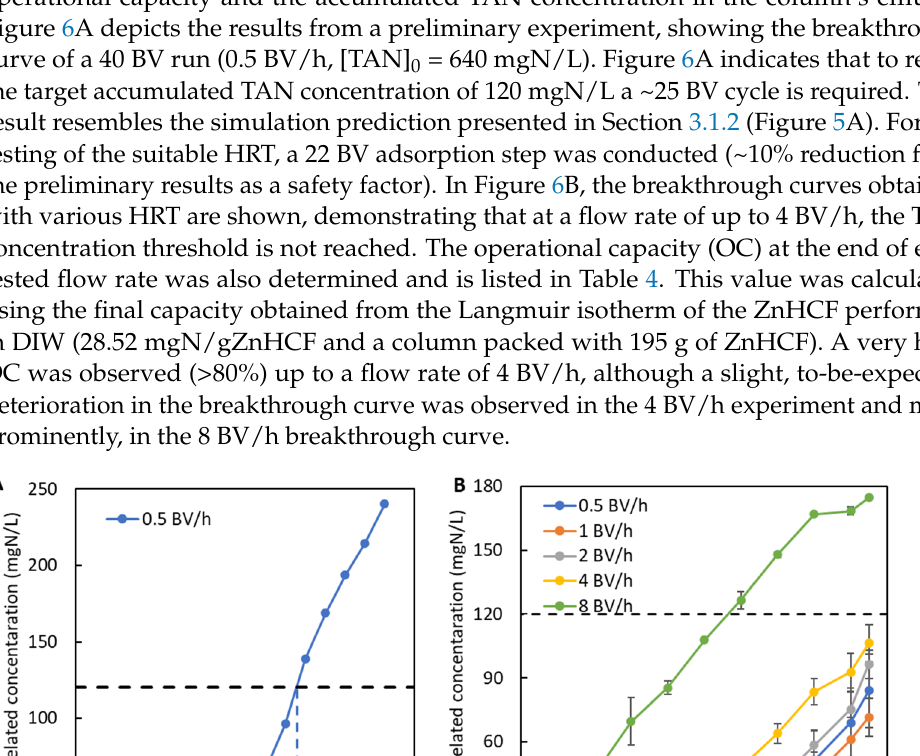
Figure 7. ( A ) Cumulative TAN concentration as a function of the number of bed volumes for the 10 full cycles performed with synthetic wastewater (filled circles), and using the 1st and 2nd batches of real WW (hollow circles). 3 BV/h, n = 10; ( B ) The cations’ composition in the exhausted regenera- tion solution as a function of completed cycles (cycle #1–10 refers to the synthetic experiment, while cycles #11–20 refers to 1st and 2nd batches of real WW experiments). Figure 7B presents the concentration of the cations (Ca 2+ , Mg 2+ and K + ) that accumu- lated in the regeneration solution over time. As can be seen, no change occurred in the concentration of the divalent cations (as their introduction to the regeneration solution was solely through residual water in the column between steps) accompanied by an